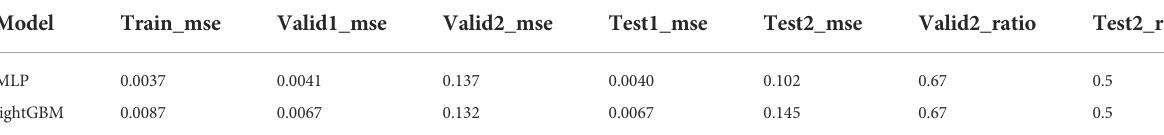
TABLE 5 Model performance with additional positive sample a6. Model